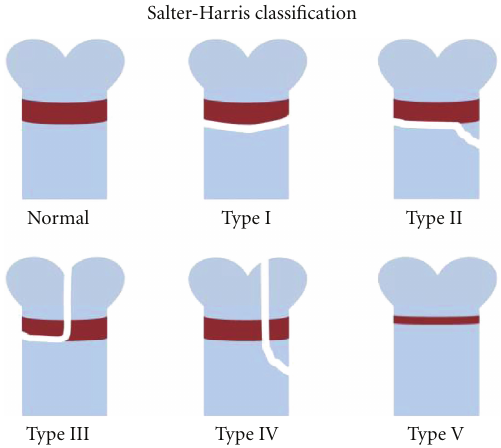
Figure 1: The Salter-Harris classification system. Types I and II fractures do not a ff ect the epiphyseal blood supply. On the other hand, types III, IV, and V do disrupt the blood supply and will more than often result in undesirable bony repair tissue-causing problems of angulations and growth